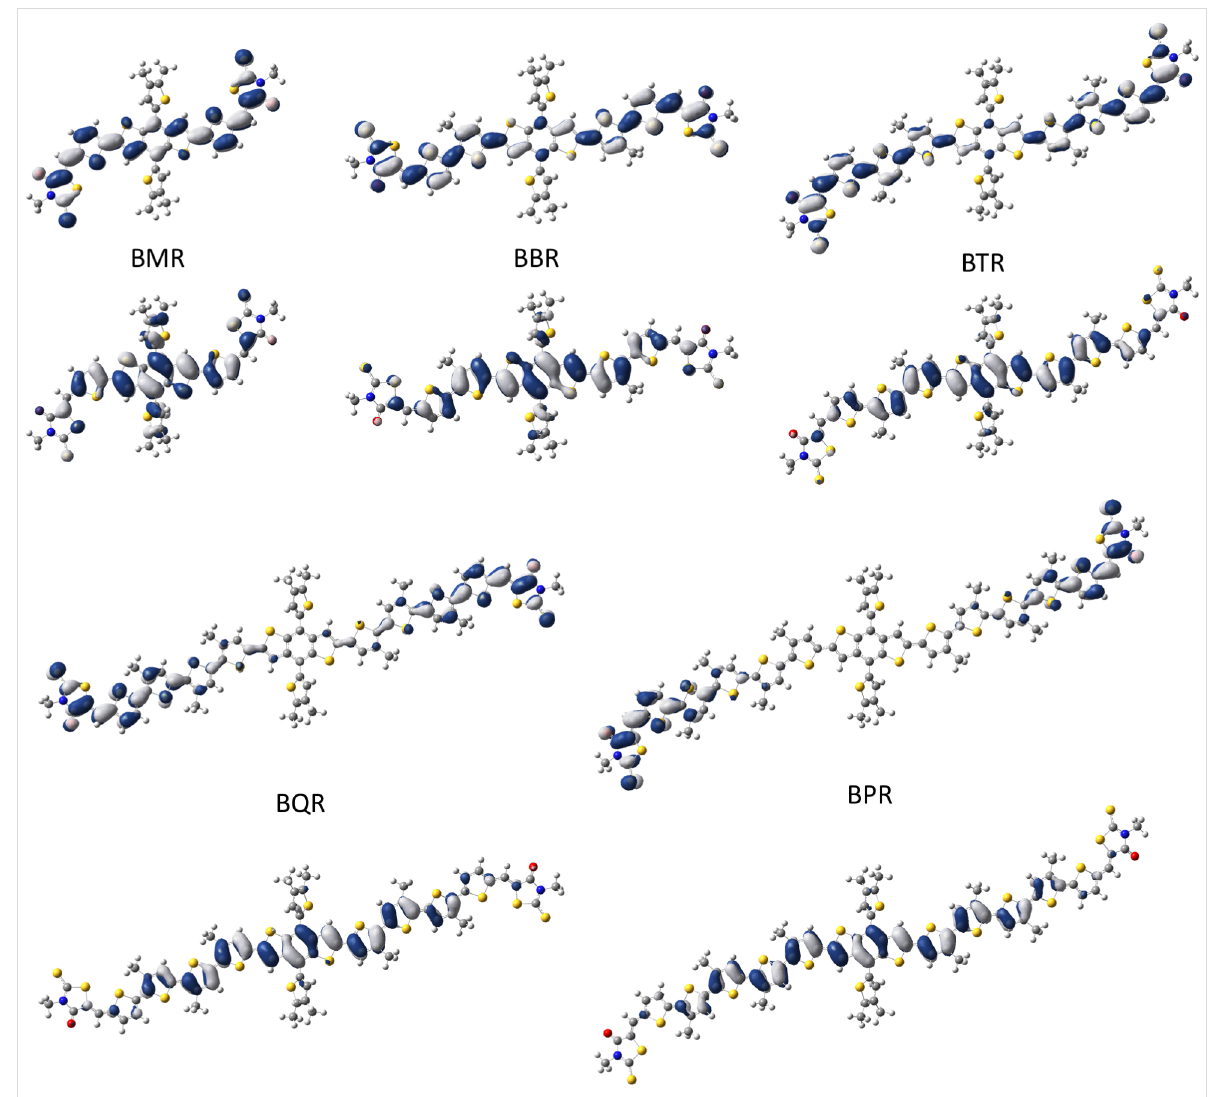
Figure 11: Optimized geometry and molecular orbital surfaces of HOMO (bottom) and LUMO (top) for the BXR series. Calculated at the B3LYP-D2/6- 311G(d,p)//PBE0/def2-TZVP level. Alkyl chains have been substituted by methyl groups.